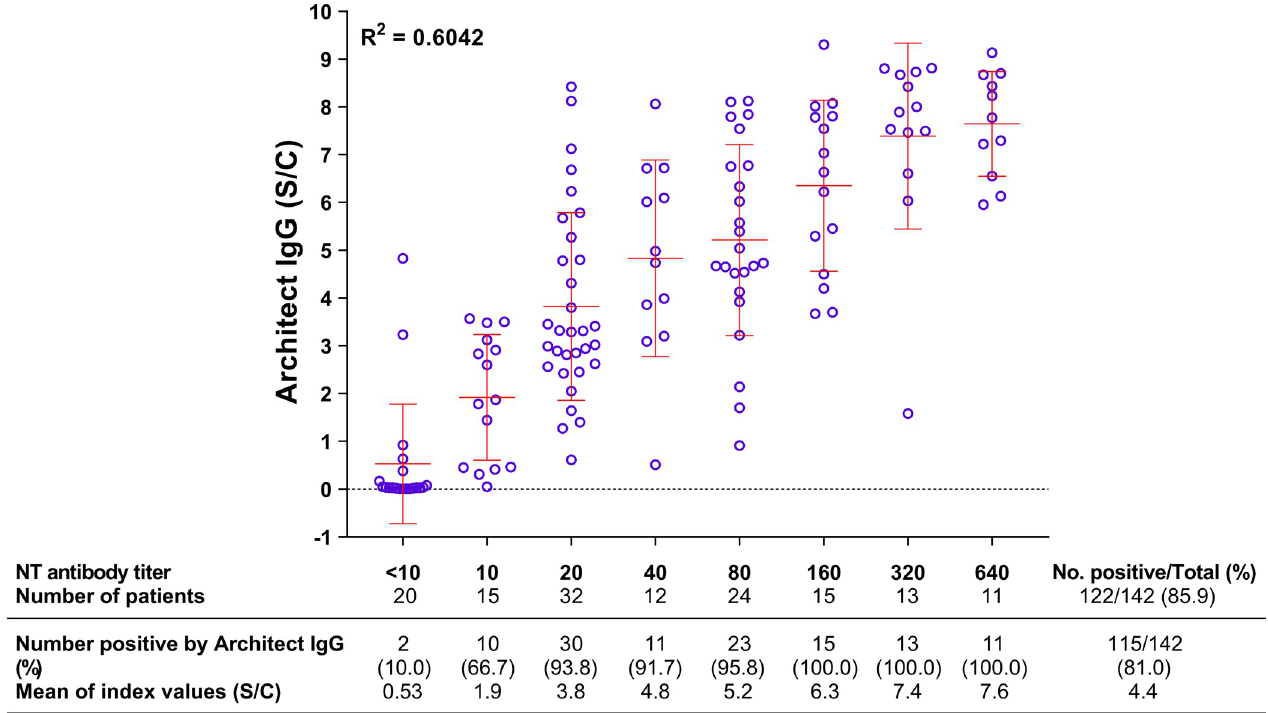
Fig 3. Correlation between NT antibody titers and Architect IgG indices in COVID-19 patients.